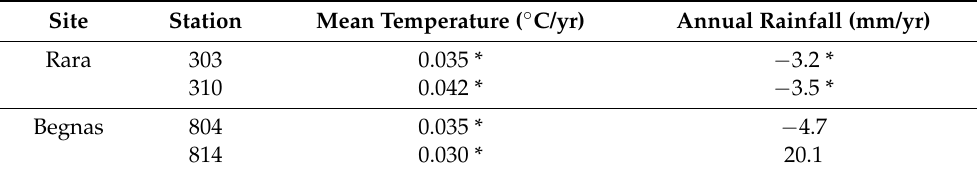
Table 4. Temperature and precipitation trends (1975–2015) in the Begnas and Rara Lakes. Site